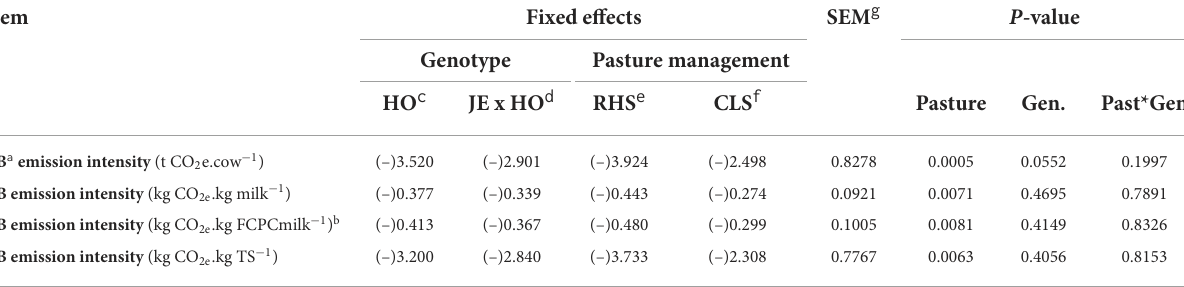
TABLE 5 Emission intensity of greenhouse gases (GHG) for two cow genotypes and two levels of intensification in grazing management systems considering the systems carbon balance.